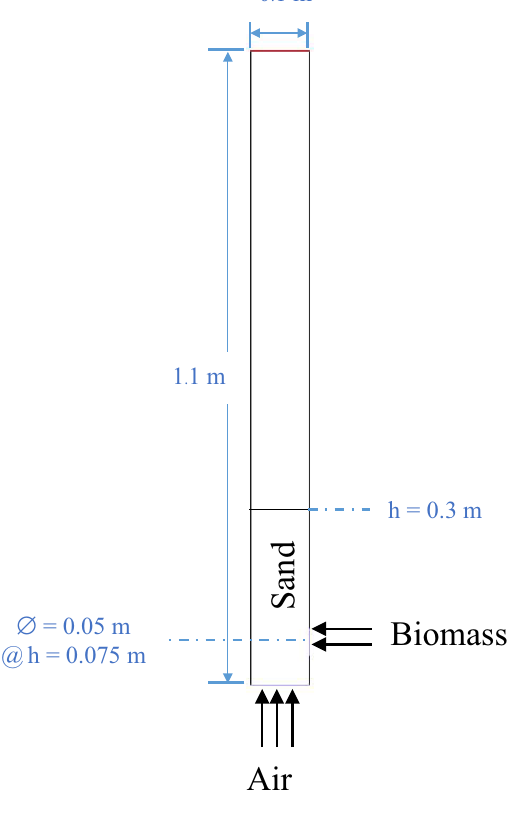
Figure 1. 2D Schematic diagram of the bubbling bed gasifier (base design).